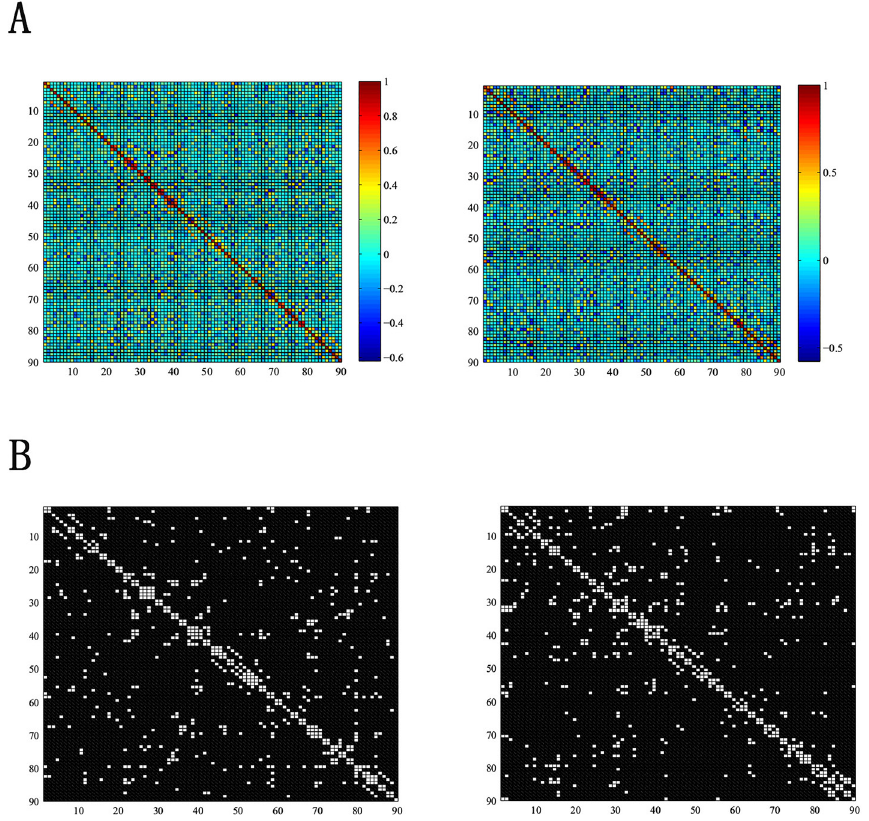
Fig 3. The interregional correlations matrix in APOE ε 4 carriers and APOE ε 4 noncarriers. A. The correlations matrices was established by computing the partial correlations between pairs of AAL areas in every group (left: APOE ε 4 carriers, right: APOE ε 4 noncarriers) B:The binarized matrices drew by thresholding the partial correlations matrices of A in a sparsity threshold (7%).